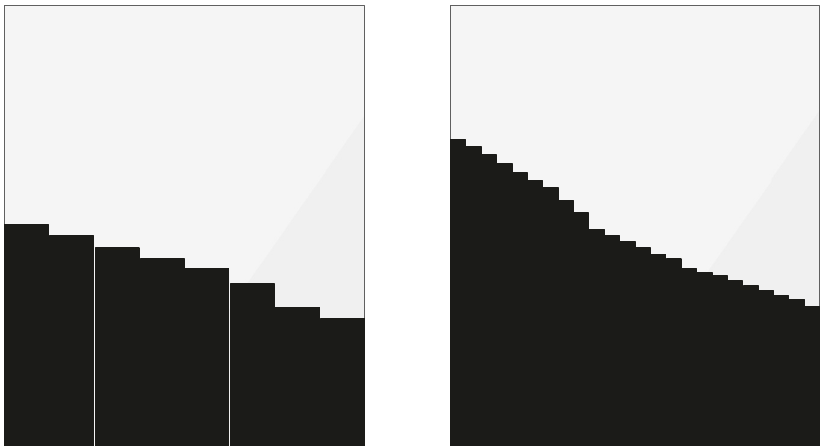
Figure 1: The sawtooth effect at different scales.